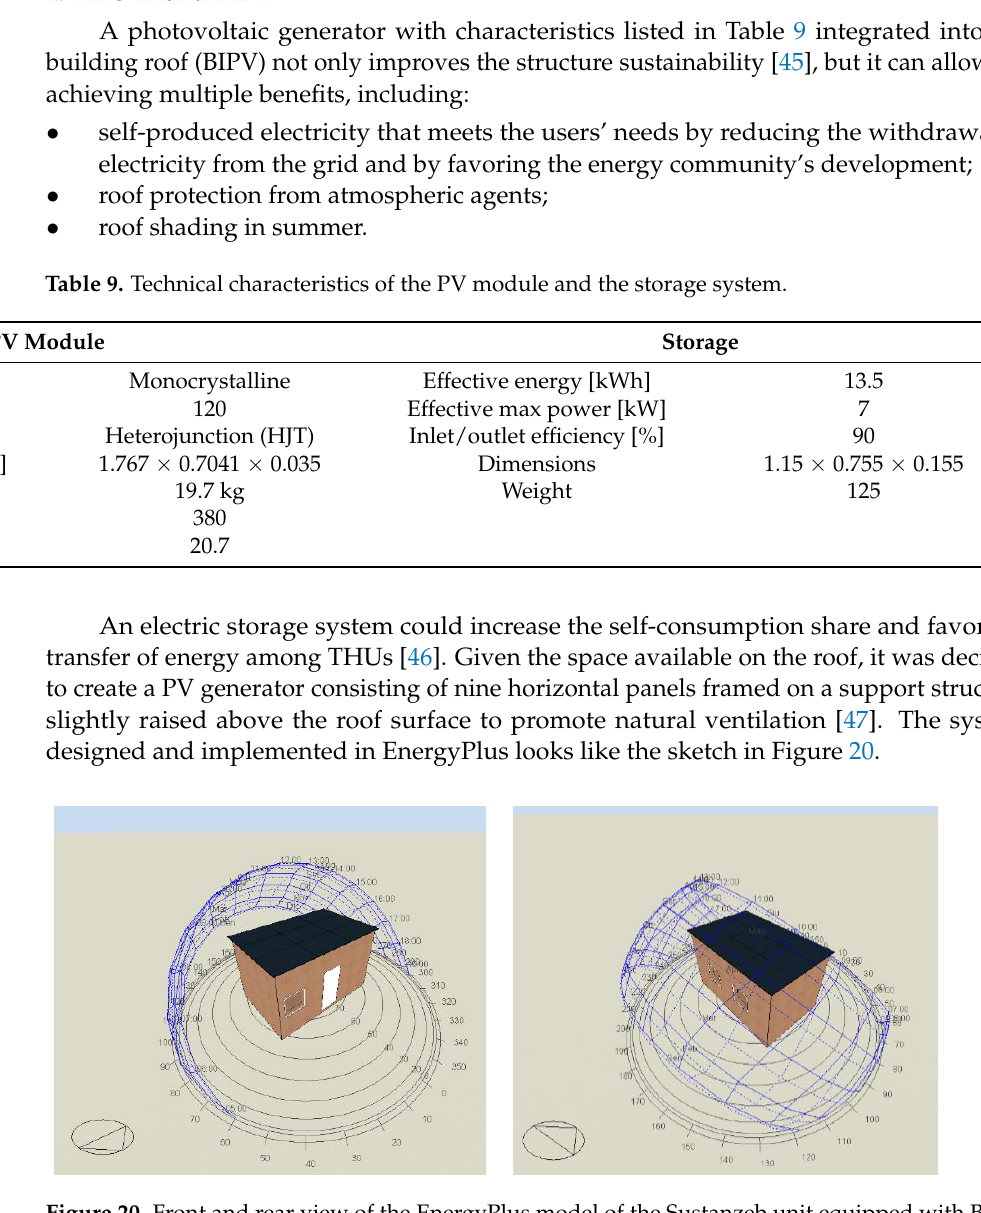
Table 8. Percentage differences in electricity consumption between different cases in heating mode (HEAT), cooling mode (COOL) and annual demand.